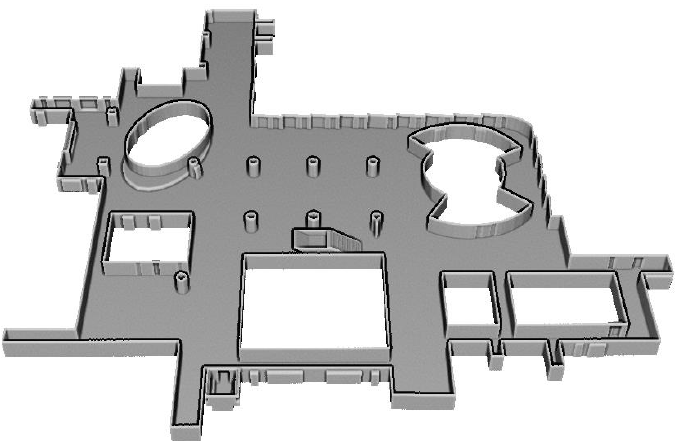
Figure 13. Point cloud of large-scale and room-less indoor space with curved surfaces and cylindri- cal